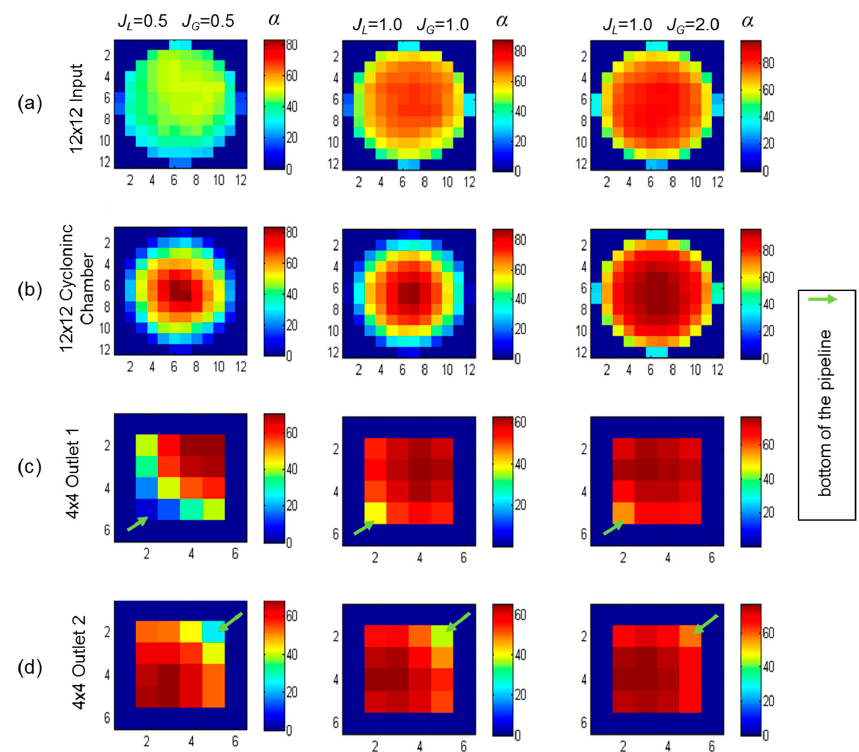
Figure 9. Axial view of the mean void fraction by WMS for three sets of gas and liquid superficial velocities: ( a ) Input using 12×12 WMS, ( b ) inside the cyclonic chamber using 12×12 WMS, ( c ) outlet 1 using 4×4 WMS, and ( d ) outlet 2 using 4×4 WMS. The bottom of the pipeline is indicated in the